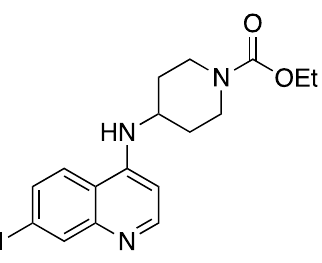
Figure 10. Structure of Ethyl 4-((7-chloroquinolin-4-yl)amino)piperidine-1-carboxylate. 4,7-Dichloroquinoline (2.00 g, 10 mmol), ethyl 4-amino-1-piperidine carboxylate (1.83 g, 11 mmol), and phenol (5.70 g, 61 mol) were heated at 90 °C in a sealed Carius vessel for 48 hours. TLC